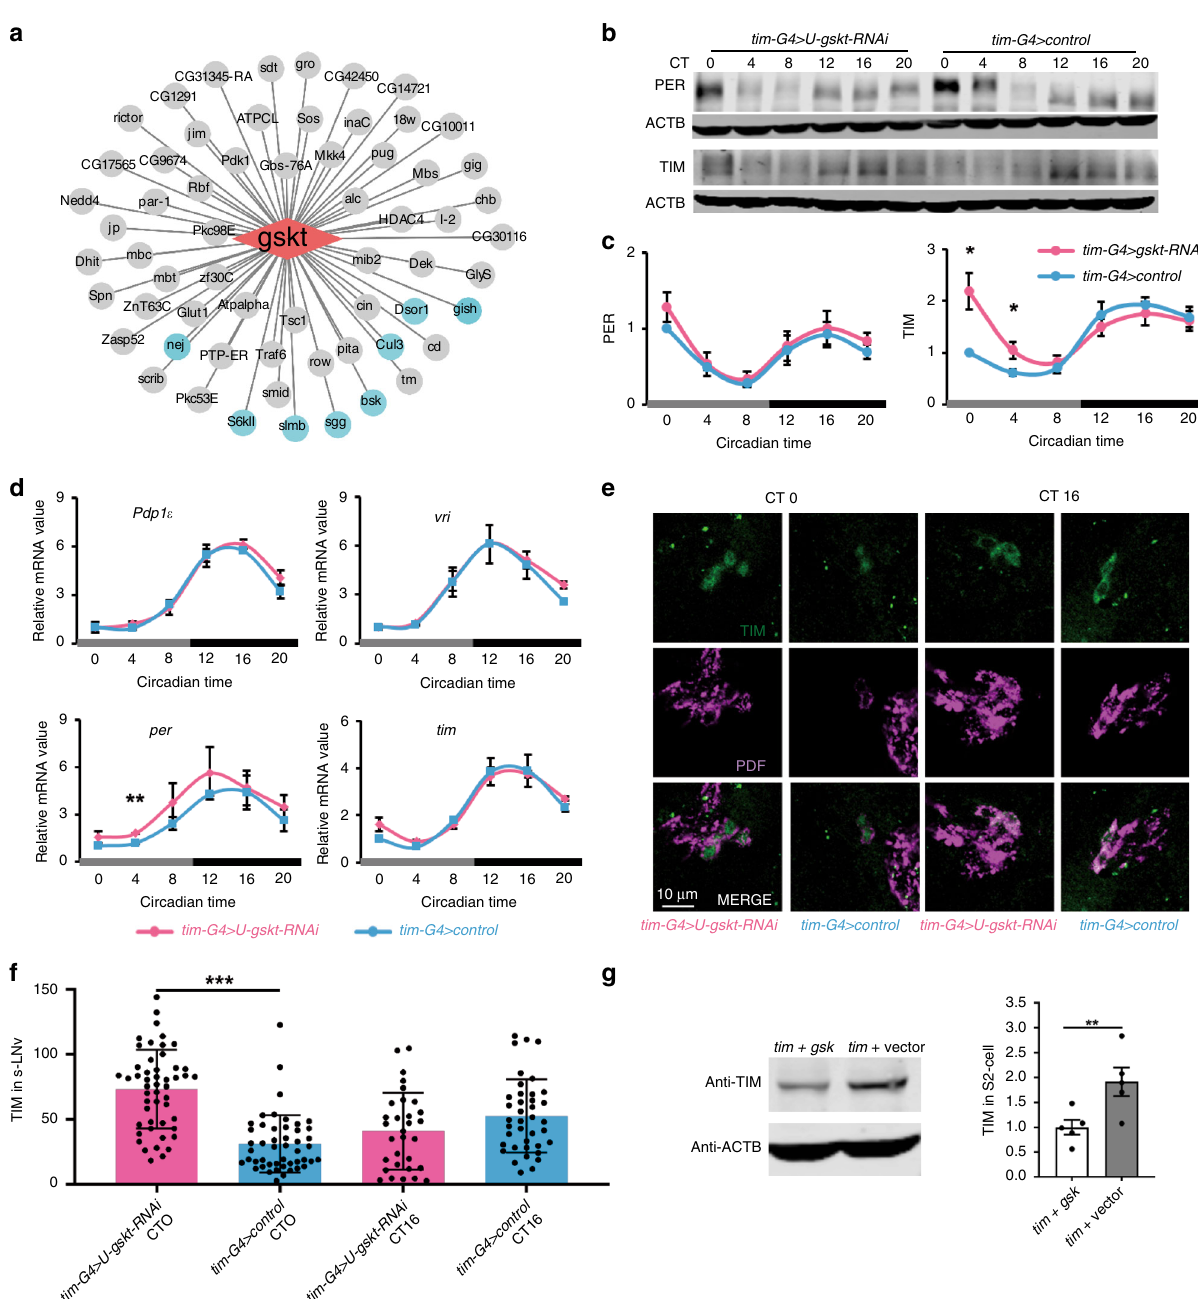
Fig. 7 Knocking down gskt signi fi cantly increases TIM protein level. a Potential substrates of GSKT fi ltered by PPI. Substrates that are involved (or potentially involved) in circadian regulation are labeled in green. b Western blots of proteins from whole-head extracts of gskt-RNAi ( timG4/ + ; Udcr2/ Ugskt-RNAi ) and control ( timG4/ + ; Udcr2/ + ) collected at the indicated circadian time. ACTB was used as a loading control. Repeated seven times independently with similar results. c Quanti fi cation of PER and TIM protein levels of blots in b ( n = 7). PER and TIM protein levels were normalized to that of ACTB. For each time series, the value of the control at CT0 was set to 1. Two-tailed Student ’ s t test, CT0, *p value = 0.0154, CT4, *p value = 0.0395. d Plots of relative mRNA abundance vs. circadian time for clock genes determined by qRT-PCR in whole-head extracts of gskt-RNAi and control fl ies collected on DD1 ( n = 3). For each time series, the value of the control at CT0 was set to 1. Two-tailed Student ’ s t test, **p value = 0.0025. e Brains from gskt-RNAi and control fl ies collected at indicated circadian time and were immunostained with TIM (green) and PDF (red) antisera. The scale bar represents 10 µ m. f Quanti fi cation of TIM protein levels in the s-LNvs of images in e (From left to right: n = 50, 48, 31, and 39; one-way ANOVA, CT0 p value = 6.84042 × 10 − 12 , CT16 p value = 0.09995). g Left panel: western blots of proteins from S2 cells co-transfected with pActin- tim and pActin- gskt or empty vector. Repeated fi ve times independently with similar results. Right panel: quanti fi cation of TIM protein levels from the blots on the left ( n = 5, two-tailed Student ’ s t test, **p value = 0.0089). ACTB was used as a loading control. Owing to large differences in molecular weight, ACTB was not ran on the same blot with PER/TIM although they were from the same sample. Error bars represent SEM. G4, GAL4; U, UAS. Source data are provided as a Source Data fi